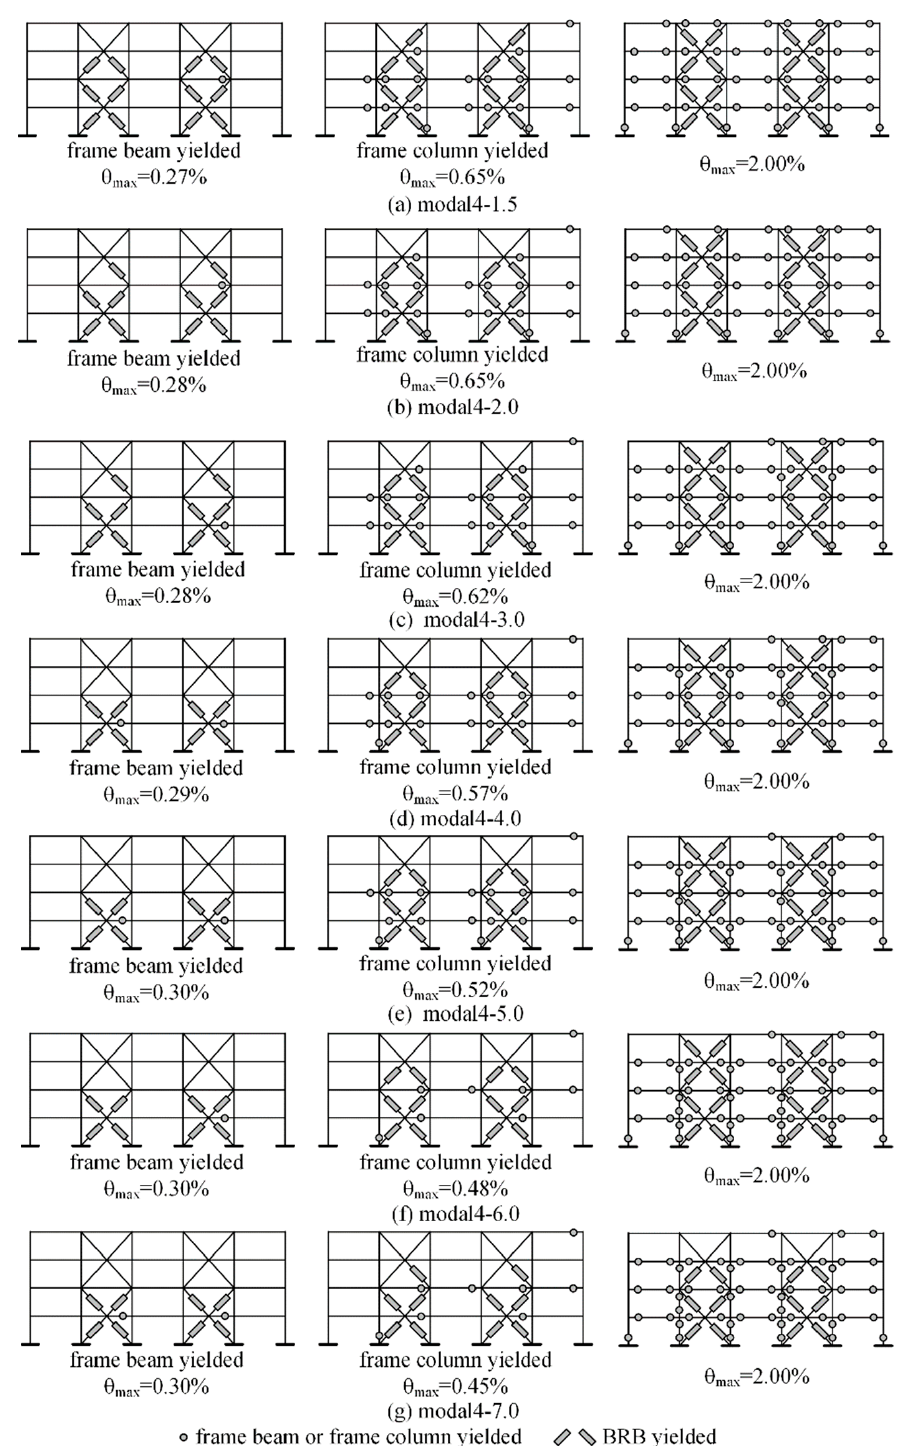
Figure 13. Beam-column yield sequence of the four-story PCF-BRB structure.